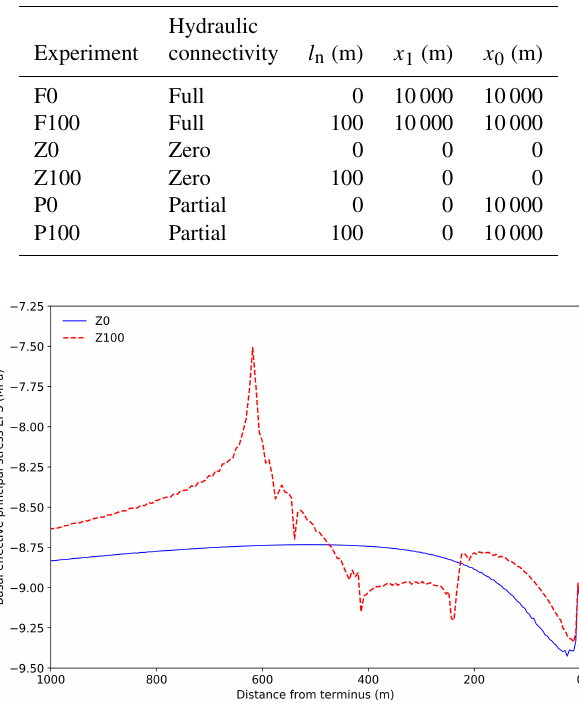
Figure 8. Comparison of basal stresses using the Coulomb sliding law with water pressure inhibited at the ice–bed interface, before (Z0) and after (Z100) cutting of a 100m notch. Ungrounding oc- curred between approximately 200 and 380m for F0, 16 and 510m for F100 and between approximately 240 and 610m for Z100. No ungrounding occurred for Z0.